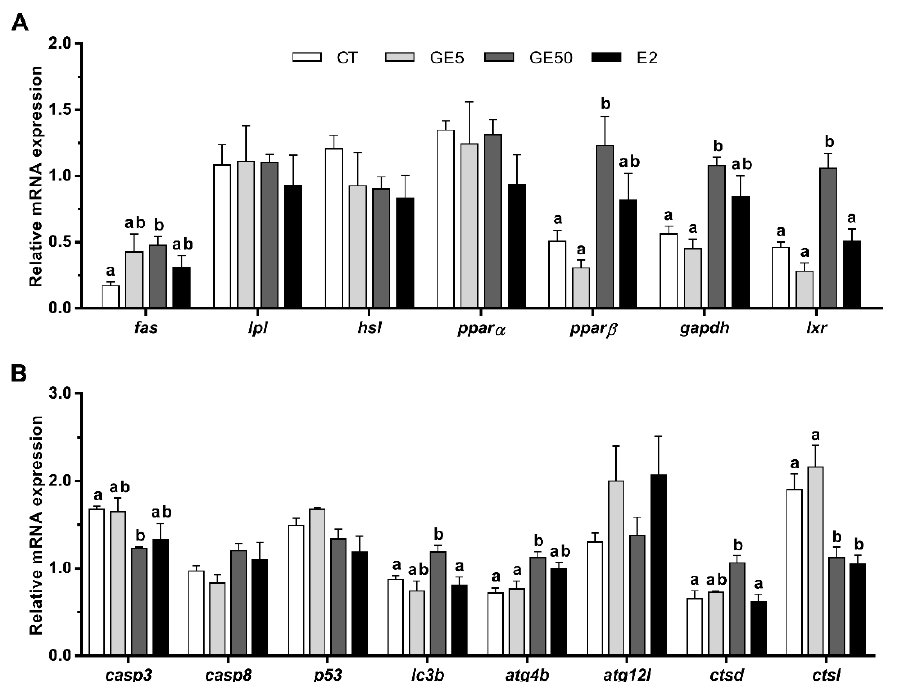
Figure 5. In vivo e ff ects on rainbow trout intraperitoneally injected with vehicle (DMSO diluted 1:3 in sesame oil) as CT, GE 5 µ g / g body weight, GE 50 µ g / g, or E2 5 µ g / g over the expression of lipid metabolism, and apoptosis- and autophagy-related genes in adipose tissue. Relative mRNA expression normalized to ef1 α and β -actin of ( A ) fas , lpl , hsl , ppar α , ppar β , gapdh , and lxr , and ( B ) casp3 , casp8 , p53 , lc3b , atg4b , atg12l , ctsd , and ctsl . Data are shown as mean + SEM ( n = 6–9). Significant di ff erences among treatments for each gene were determined by one-way ANOVA and are indicated by di ff erent letters ( p < 0.05). When two groups share at least one letter, they are not statistically di ff erent. CT: Control; GE: Genistein; E2: 17 β